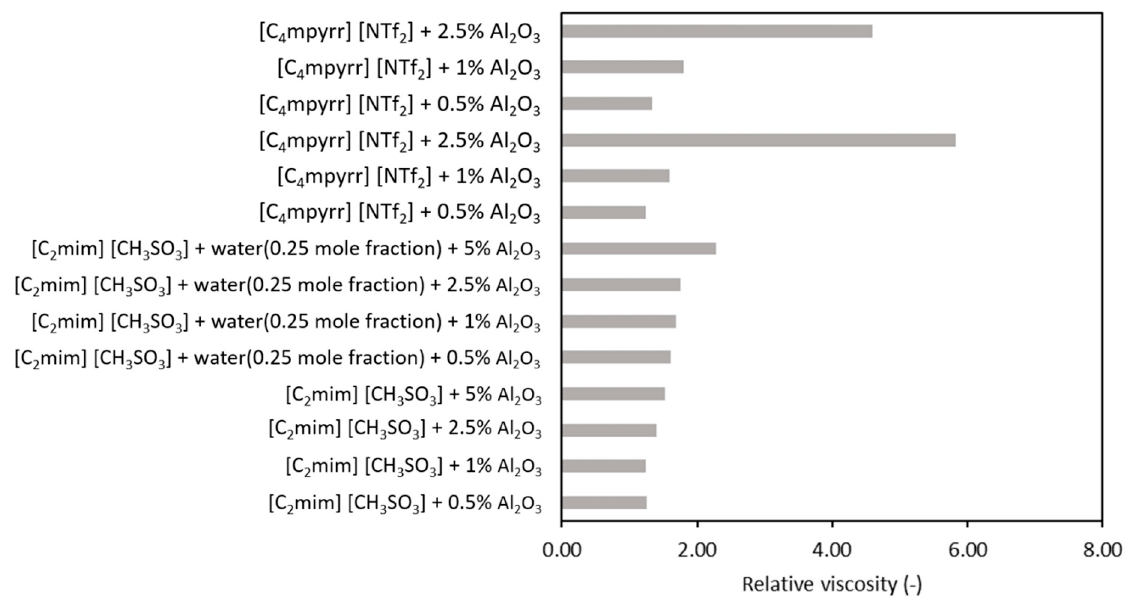
Figure 8. Influence of the base fluid on relative viscosity values of fluids with Al 2 O 3 [62,65]. Viscosity increase mechanisms are to be elucidated, and several authors attributed this growth to strong interactions between graphene sheets and IL molecules (see Pamies et al. [26]). Plus, Pamies et al. [38] discussed the increase in concentration based on in- creases in the internal shear stress, with the subsequent viscosity increase. Even though in the literature, there are numerous models for viscosity estimation, no theoretical correlation was found acceptable to estimate both nanofluids or other nano- particle-enhanced fluids’ viscosity behavior. However, a number of papers are proposing the Krieger–Dougherty or Pastorizza–Galllego models (see, for example, the work of Chereches et al. [65] and Pastorizza–Galllego et al. [76]), which seems to describe well the experimental results. 3.2.3. Specific Heat Specific heat results are also contradictory, as can be clearly seen from Table 5, and it is concluded that the experimental values may greatly depend on the chemical structure of the ionic liquid and of its molecules interaction with nanoparticles. Based on the previous reports on the simple molecular solvents-based nanofluids, the mechanism of the heat capacity enhancement of ionanofluids is probably driven by the existing interfacial nanolayering occurring on the surface of nanoparticles [45]. Zhang et al. [68] found that the decreases noticed for the GNPs-dispersed nanofluids are less than those reached by the SWCNT and GE; the explanation came from the fact that the zero dimensional GNPs has higher thermal energy density than the two-dimen- sional GE and the one-dimensional SWCNTs. Some other studies reported the possibility of mesolayers overlapping, as a mecha- nism of variation of specific heat for nanofluids also extended to the ionic liquids with nanoparticles (see Oster et al. [45]). In the case of specific heat, since the results are scattered, it is hard to make a good comparison on nanoparticles or ionic liquid influence on the actual variation of the exper- imental values.